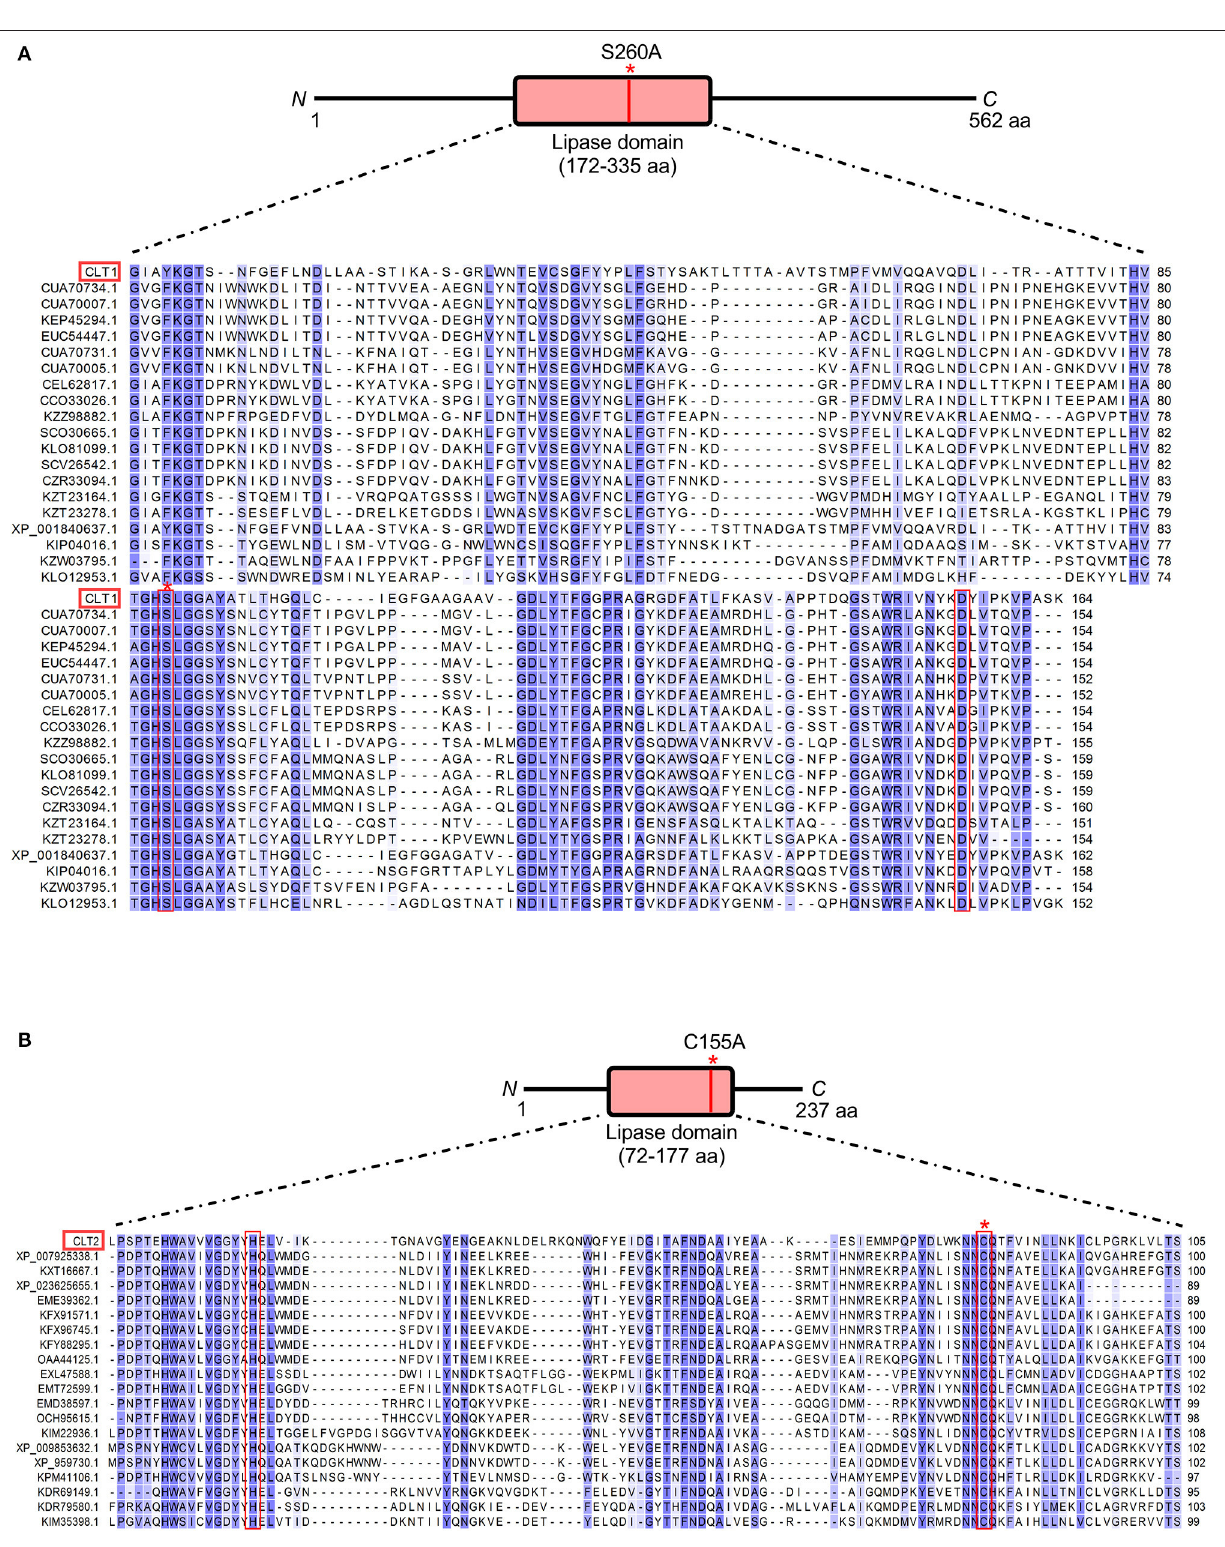
FIGURE 2 | Sequence alignments of CLT1 and CLT2 lipase domains with homologous sequences from NCBI. Amino acid sequences of CLT1 (A) and CLT2 (B) lipase domains were BLASTed against the NCBI non-redundant protein sequence database and the top 20 hits were aligned. All hits originate from fungi and 33 of them